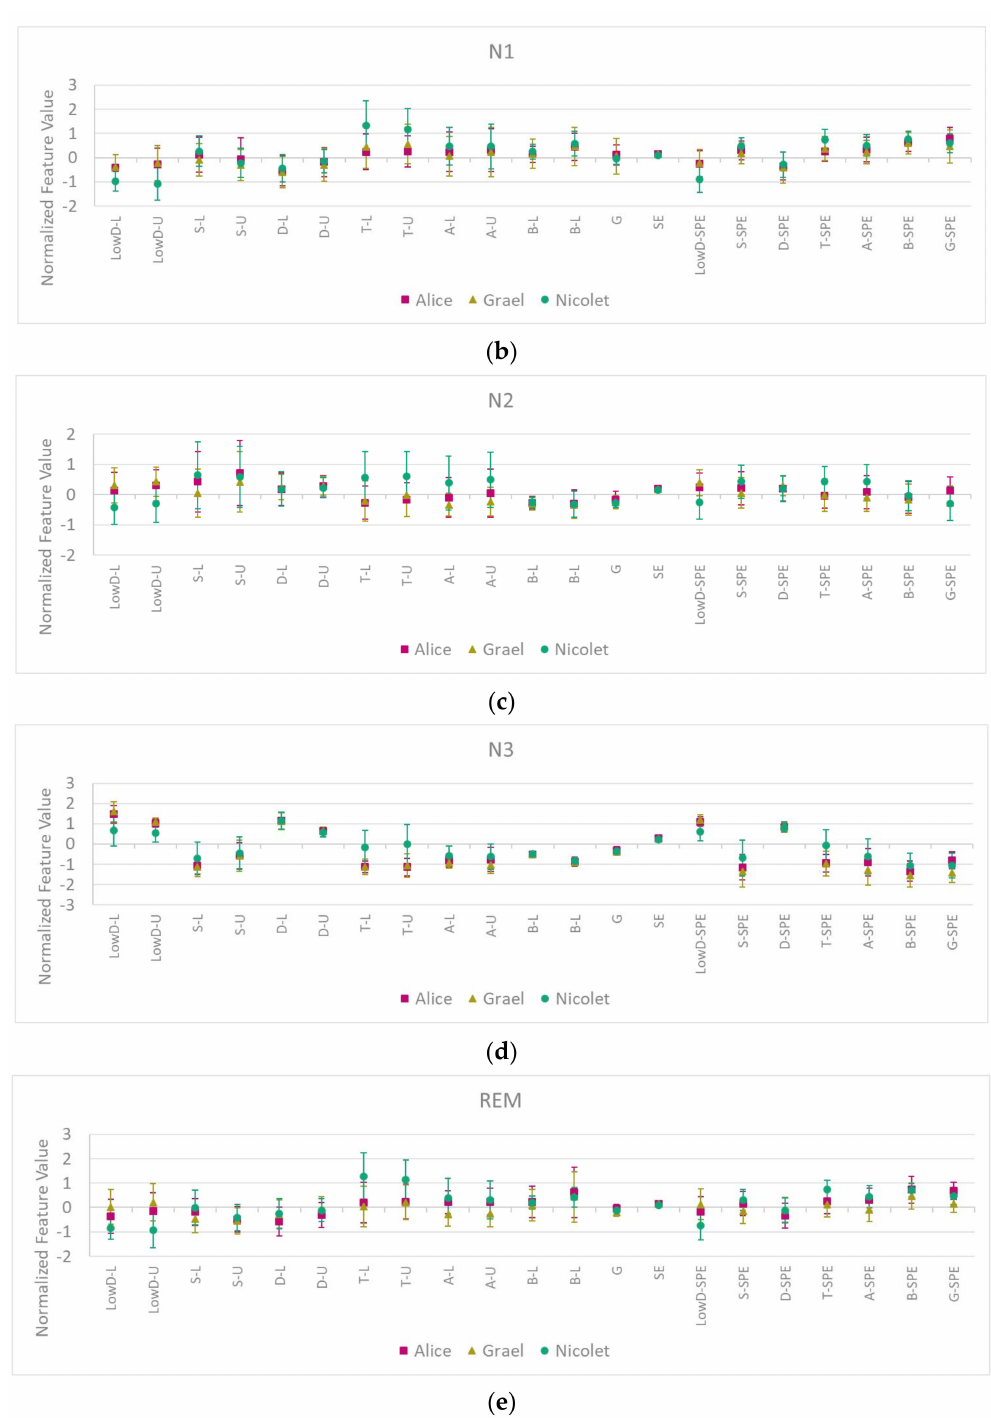
Figure 5. Distribution of extracted features from different PSG systems separated by sleep stages. Each feature value was normalized against itself so that all of the features could be depicted in the same plot. Most features showed a similar distribution across all three systems, although features related to the low delta and theta bands showed a slightly different distribution in the Nicolet dataset. Those from the Alice and Grael samples are mostly overlapped, while those from Nicolet are not. ( a ) Wake stage; ( b ) N1; ( c ) N2; ( d ) N3; ( e )